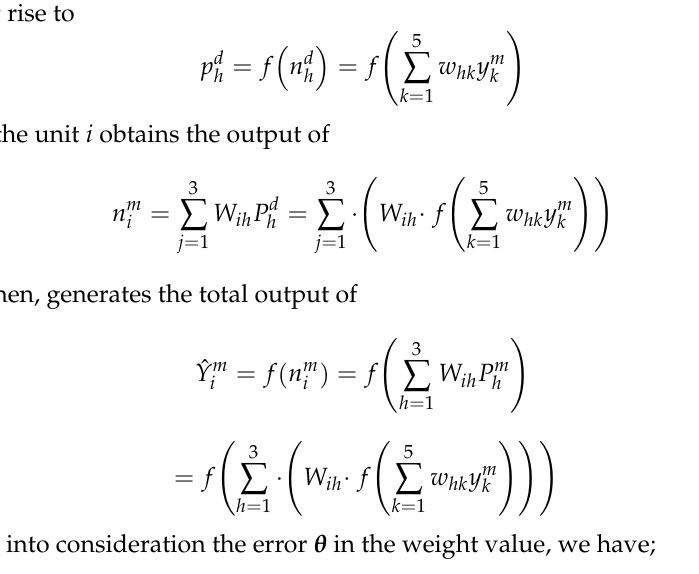
Figure 4. A two-layer Neural